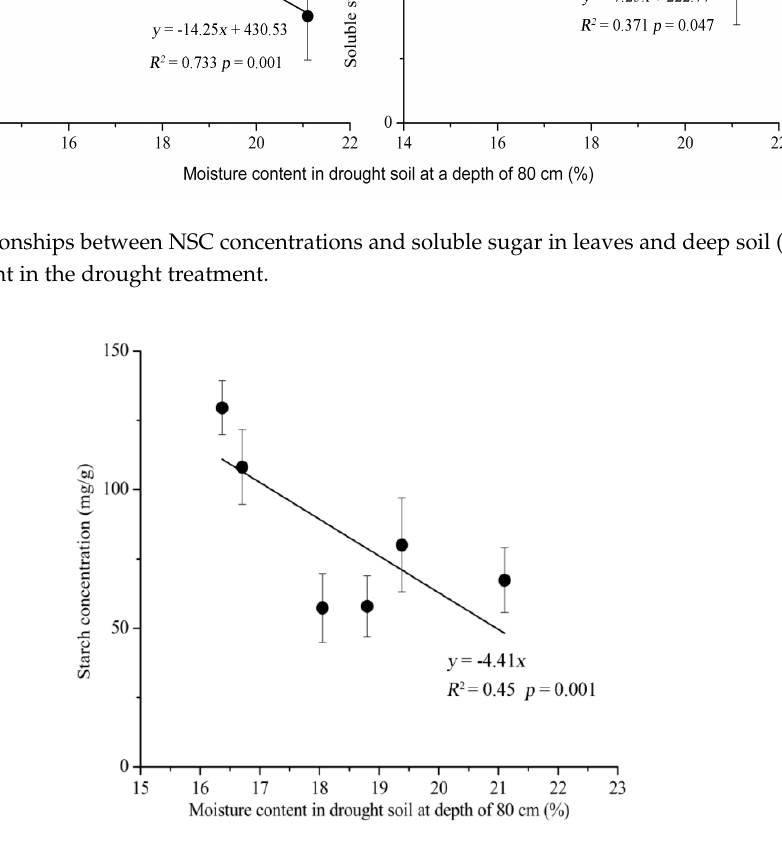
Figure 9. Relationships between concentrations of starch in leaves and deep soil (80 cm) moisture content in the drought treatment for days 115–542.